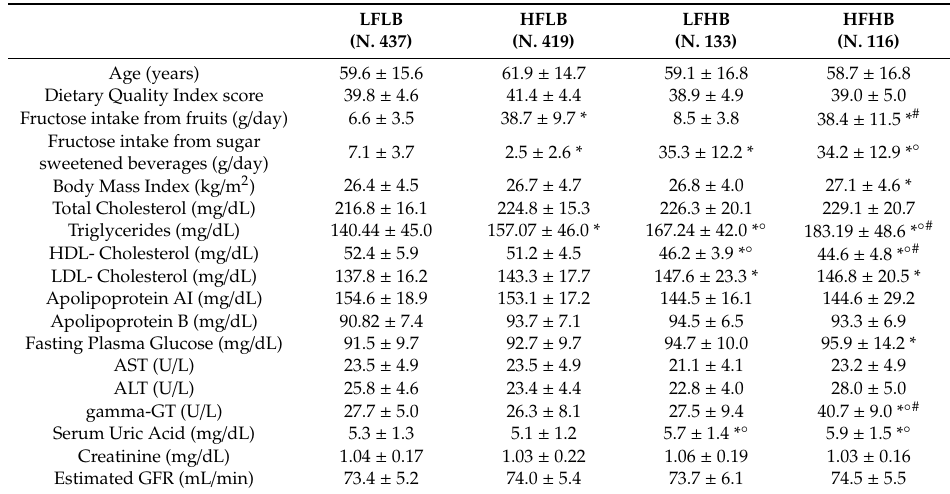
Table 2. Age, BMI, dietary and laboratory characteristics of the studied population subgroups (values reported as mean ± standard